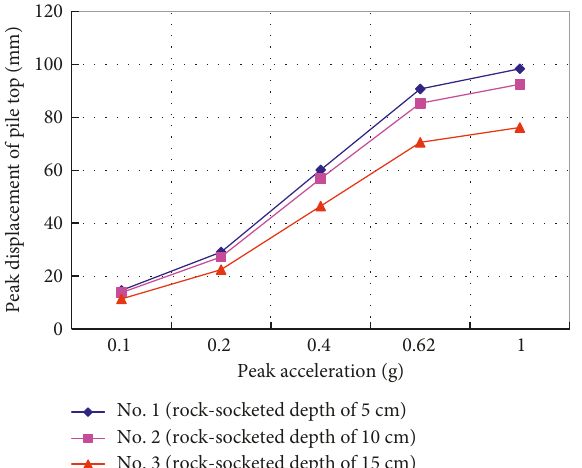
Figure 5: Relationship between peak displacement of the pile top and anchor inclination angle under different working conditions.